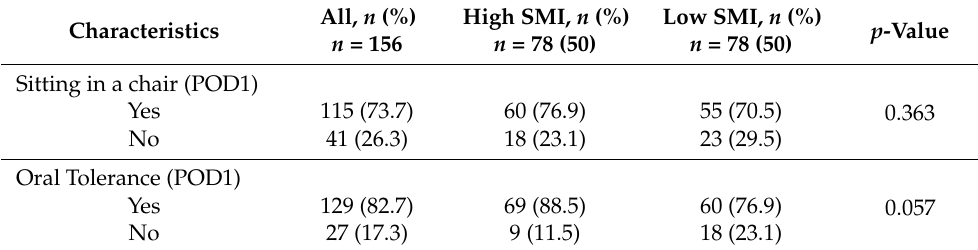
Figure 4. Dispersion diagram correlating complications between BMI and SMI in women. Therefore, we propose a new classification based on Dolan´s, called the Body Com- position Elche (BCE) classification, for further analysis and classification of the patients’ body composition (BC) into low- or high-risk groups. Low-risk BC is defined as a high